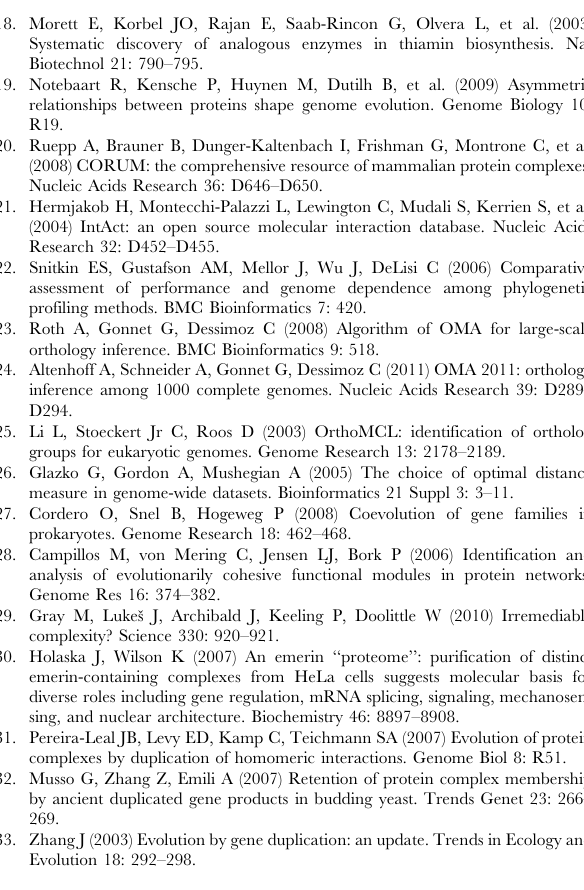
Figure S1 Distribution of the profile relationships of co-complex protein pairs in the two complex data sets (A–D) and yeast interactions (E–F) for the OMA and MCL algorithm. Figure S2 Frequency of open triangles as a function of the triplet score for co-complex protein pairs (A–D) and yeast interactions (E–F) for the OMA and the MCL algorithm. Figure S3 Heat maps showing the enrichment of co-complex pairs (A–D) or yeast interactions (E–F) as a function of pairwise profile similarity scores and triplet-based complementarity scores for the OMA and the MCL algorithm. Figure S4 Distribution of profile-pair types among co-complex proteins (A–B) and yeast interactions (C) for the OMA and the MCL algorithm. Figure S5 Spearman correlation ( r and p-value) for the fraction of different triangle types over bins for the yeast interactions. Figure S6 Spearman correlation ( r and p-value) for the fraction of different triangle types over bins for the human complexes.